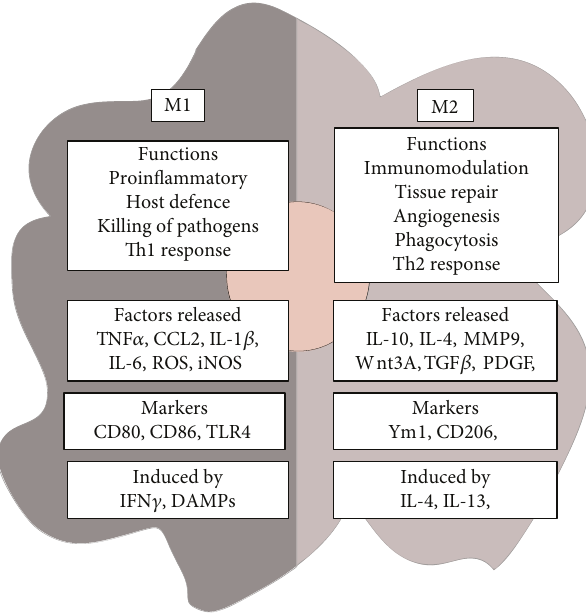
Figure 2: M1/M2 paradigm of macrophage polarisation. The M1/M2 paradigm describes alternative states of macrophage polarisation with each exerting di ff erent functions in in fl ammation and fi brosis. The activation state adopted by macrophages is dependent on signalling molecules from their